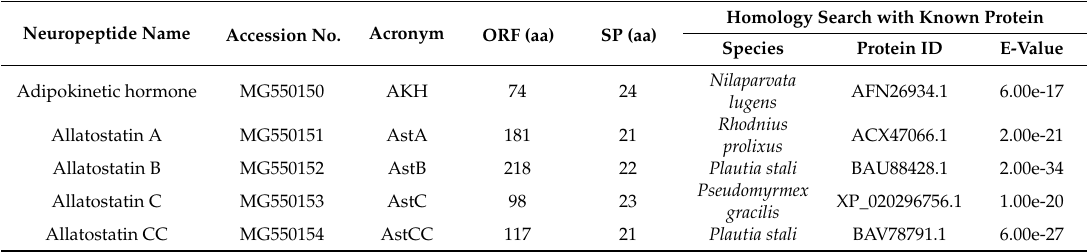
Table 1. Neuropeptides identified from D. citri . ORF, open reading frame; SP, signal peptide; aa, amino acid.